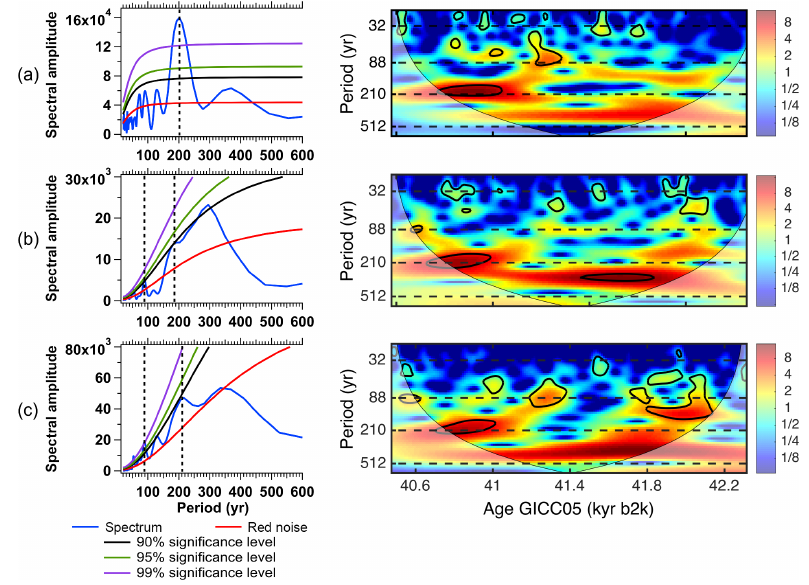
Figure 4. Fourier (left) and wavelet (right) analyses of our 10 Be flux records at (a) NGRIP, (b) EDC and (c) EDML from 40.480 to 42.320kyr b2k on the GICC05 age scale. The solid black lines on the wavelet panels indicate the regions which are significant at the 95% level.